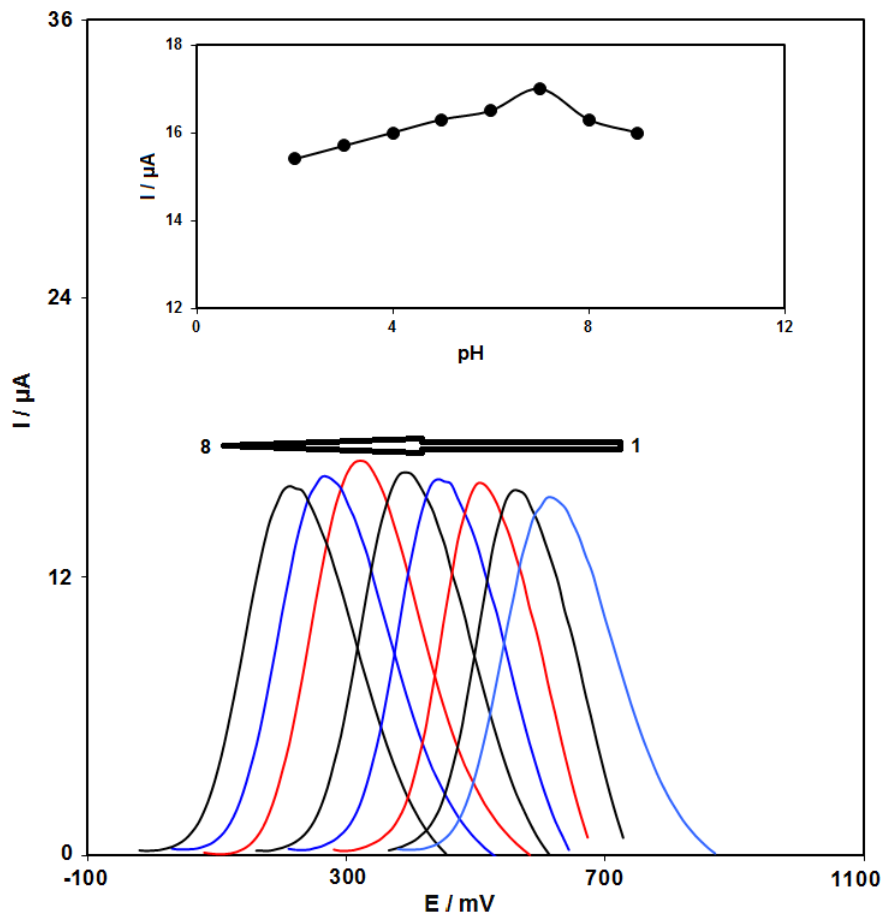
Figure 6. Differential pulse voltammetric graphs at the GO/ZIF-67/SPE in 0.1 M PBS with different pH values containing 200.0 μ M of epinine. Numbers 1–8 correspond to pH values of 2.0, 3.0, 4.0, 5.0, 6.0, 7.0, 8.0, and 9.0. Inset: plot of Ip vs. pH.